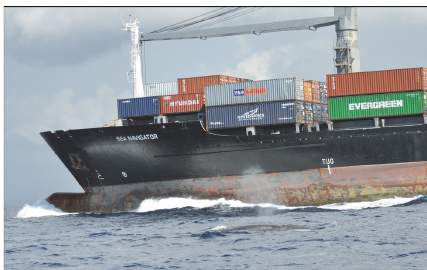
Figure 6: A Bryde’s whale surfaces in close proximity to a cargo ship at Mirissa.